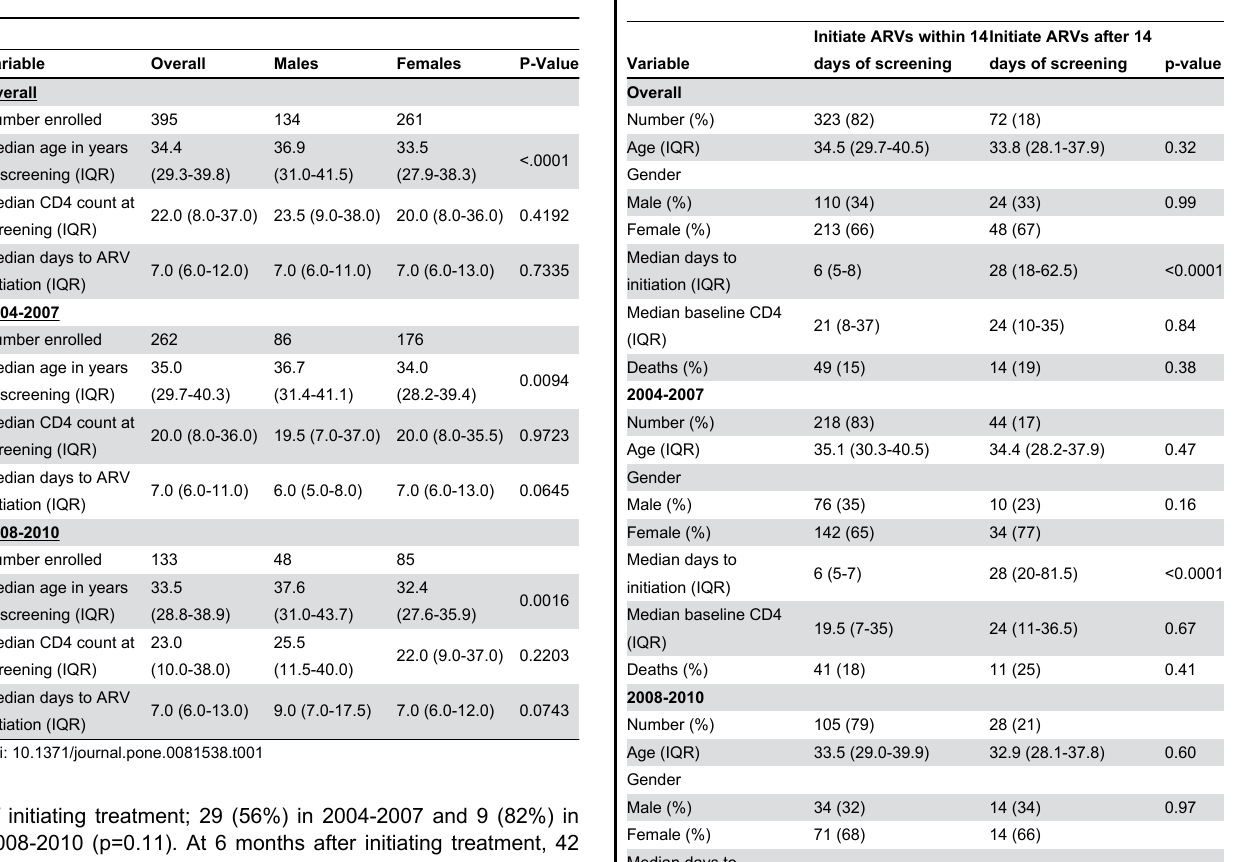
Table 2. Time of initiating